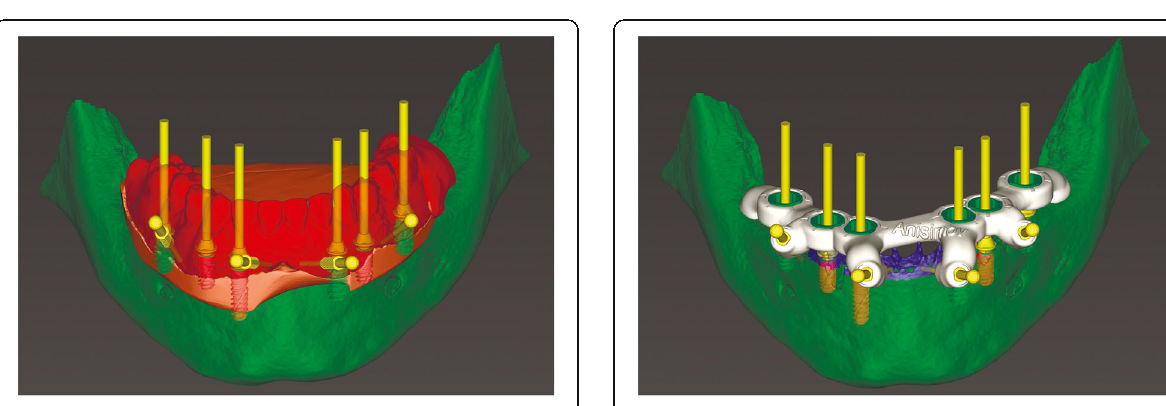
Fig. 4 Computer-aided design of surgical templates for implant